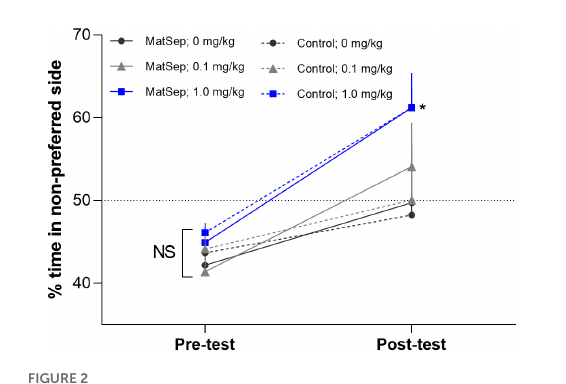
FIGURE2 MatSep has no effect on CPP to Meth. The data reflect% time spent in the non-preferred side as a function of the total 15 min test period. These values were calculated during the pre-test before conditioning and during the post-test after the conditioning. The magnitude of CPP was compared in control and MatSep rats ( n = 5–8/group) before (pre-test) and after (post-test) conditioning with 3 doses of Meth (0, 0.1, or 1.0 mg/kg, i.p.). The results revealed that CPP is produced by administration of the highest dose of Meth (* p ≤ 0.05), but MatSep has no additional effect on this response. The dotted line at 50% demarcates where there is no shift in preference